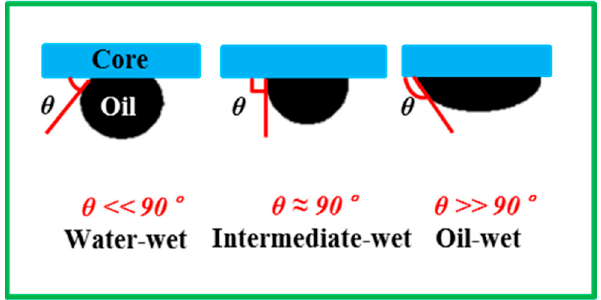
Figure 8. A schematic diagram of rock wettability conditions of a rock-brine/nanofluid-oil system [41].